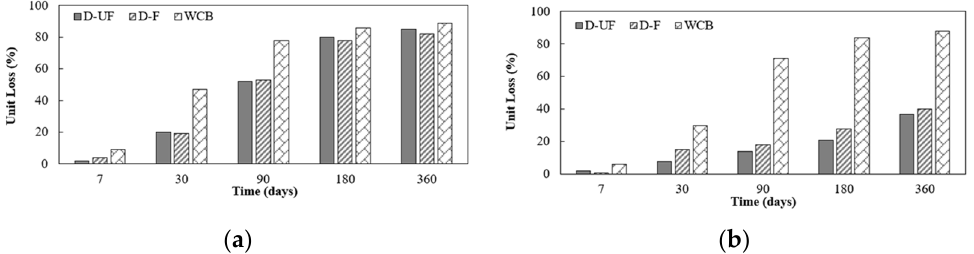
Figure 3. Percentage of unit loss of the three prepared crude extracts in solution at different storage times at ( a ) RT and ( b ) 4 °C. (D-UF) Dehusked Unfiltered, (D-F) Dehusked Filtered, (WCB) Whole Crushed Beans.